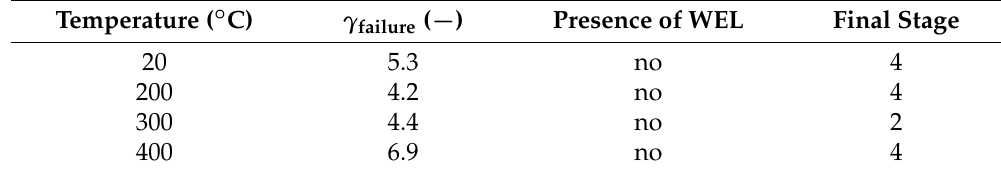
Table 8. Synthesis for the monotonic tests.